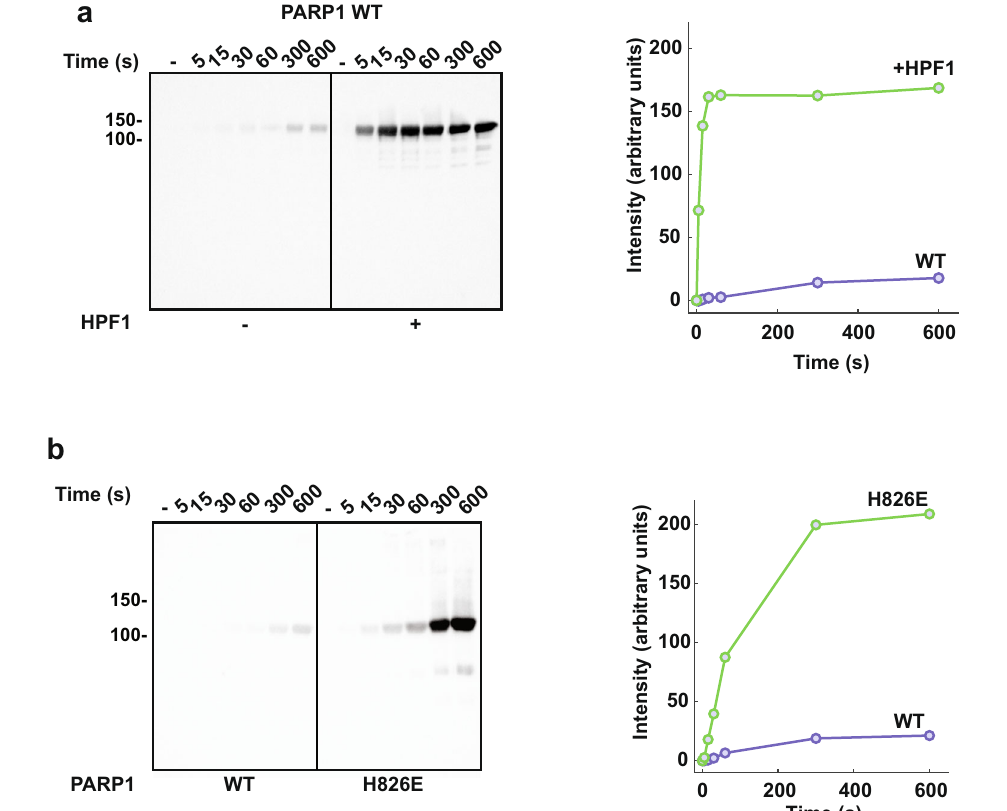
Fig. 5 HPF1 stimulates initiation in PARP1. a PARP1 (1 μ M) was incubated without or with HPF1 (0.1 μ M) for 10 min at RT in the presence of DNA (1 μ M). 1 mM NAD + was added for various time points as indicated, and reactions were quenched with 500 μ M talazoparib. PARG (1 μ M) was added and incubated for 1 h at RT. Reactions were resolved by 12% SDS-PAGE and a western blot was performed using a mono-ADP-ribose-binding reagent. The bands corresponding to mono-ADP-ribosylated PARP1 were quanti fi ed using ImageJ and plotted as intensity over time. b Reactions were performed as in panel a without HPF1 and comparing PARP1 WT to PARP1 H826E. Reactions were resolved by 7.5% SDS-PAGE and a western blot was performed using a mono-ADP-ribose binding reagent. For 5a and b, a representative image from three independent experiments is shown. Numbers on the left side of the blots represent molecular weight marker locations (values in kDa). Source data are provided as a Source Data fi